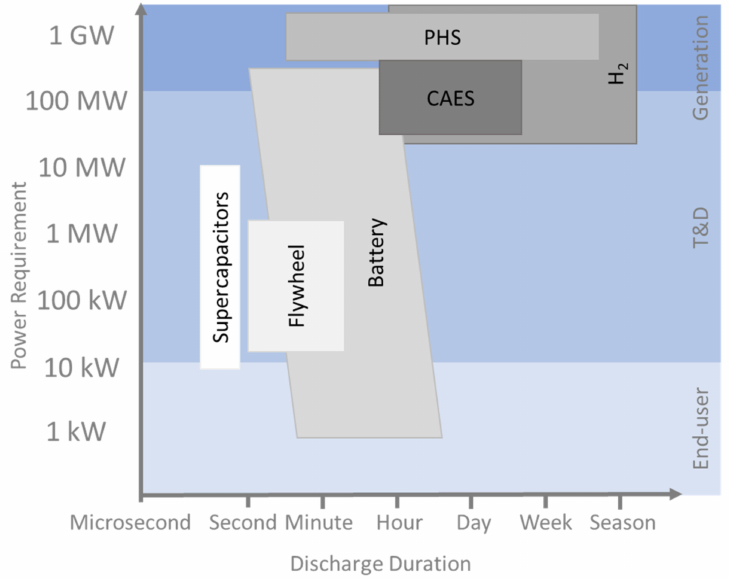
Figure 1. Storage options for electricity from renewable energy (adapted with permission from [18] IEA 2015). CAES = Compressed Air Energy Storage, PHS = Pumped Hydrostorage, T&D = Transmis- sion and